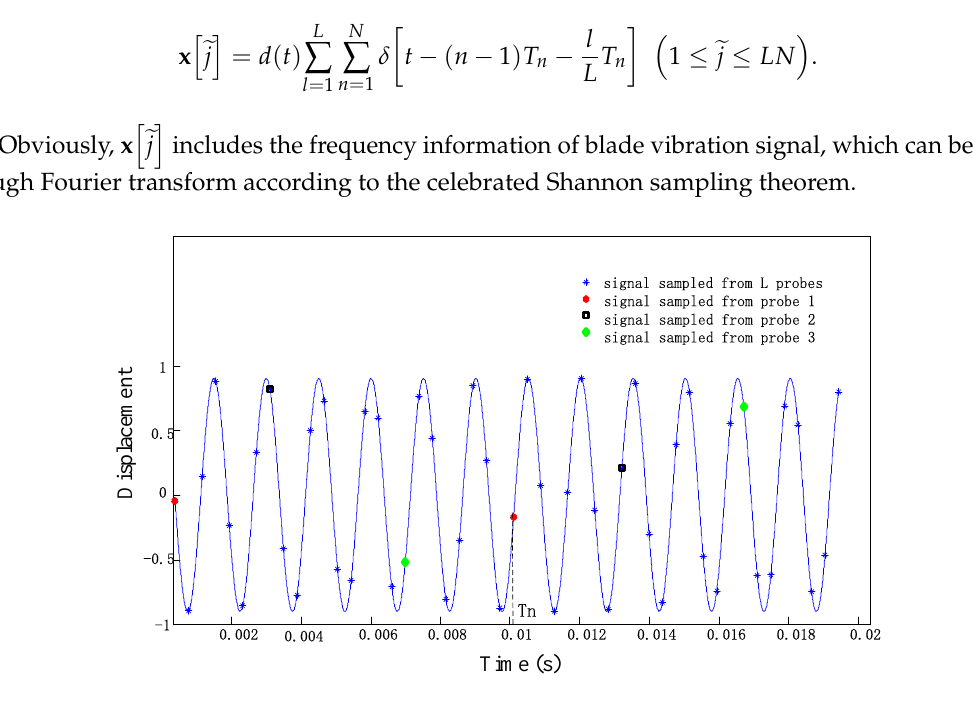
Figure 2. Blade tip displacement data sampled by different sensors in two rotating periods.